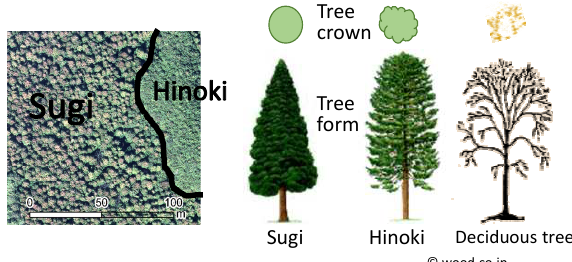
Figure 1. Knowledge of forestry for interpretation LiDAR transmits a light pulse and records the time that the pulse returns, which creates a 3D point cloud of targets. Since typical convolutional neural networks require a regular shape for input data such as a collection of images, deep learning architectures with 3D voxels have been explored (Maturana et al., 2015). Although (Qi et al., 2017) shows that raw point clouds perform better than voxelization architecture on classification and segmentation by selecting informative points through the network, they assume point clouds taken from a close range such as CAD model, Kinect data, and structure from motion in proximity photographing as the input dataset. The point density of airborne LiDAR taken over a forest area, on